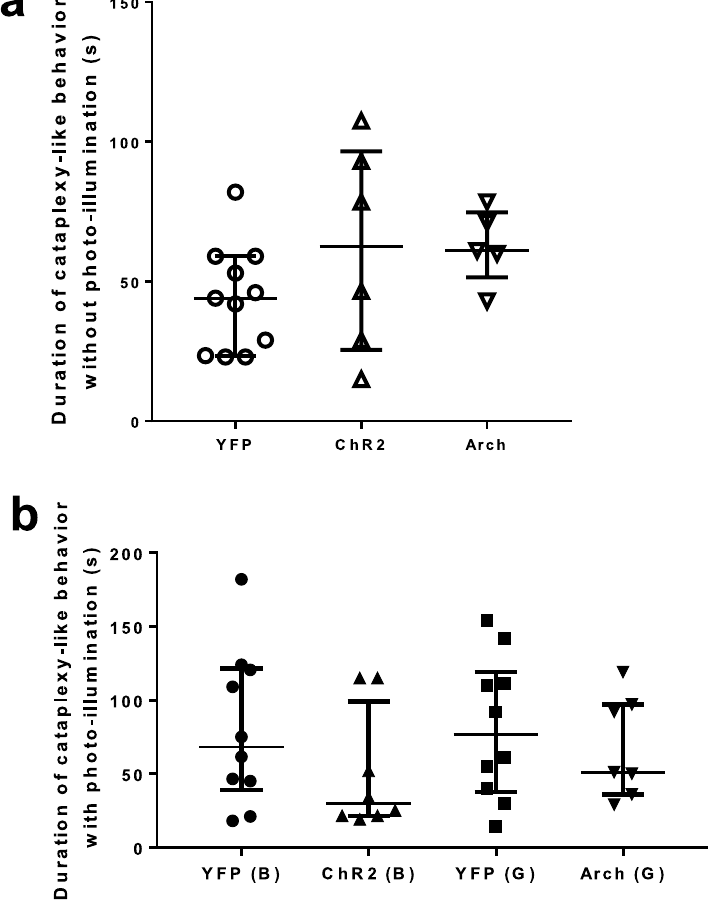
Figure 3. The rostral NAc shell did not regulate the duration of photo-illumination-induced cataplexy-like behavior. ( a ) Duration of cataplexy-like behavior without photo-illumination. The possible effect of AAV expression in the rostral NAc shell on the duration of spontaneous cataplexy-like behavior was examined without photo-illumination. No such effect was observed (Kruskal–Wallis test, P = 0.1923, YFP n = 11, ChR2 n = 6, Arch n = 5). Horizontal bars represent the median with the interquartile range. ( b ) Duration of cataplexy- like behavior with photo-illumination in the rostral NAc shell. The plot shows the median duration of cataplexy- like behavior with photo-illumination. Blue/green photo-illumination to ChR2/Arch group did not affect the duration of cataplexy-like behavior induced by photo-illumination (Kruskal–Wallis test, P = 0.4703, YFP (B) n = 10, ChR2 (B) n = 8, YFP (G) n = 10, Arch (G) n = 7). The data represent the median with an interquartile